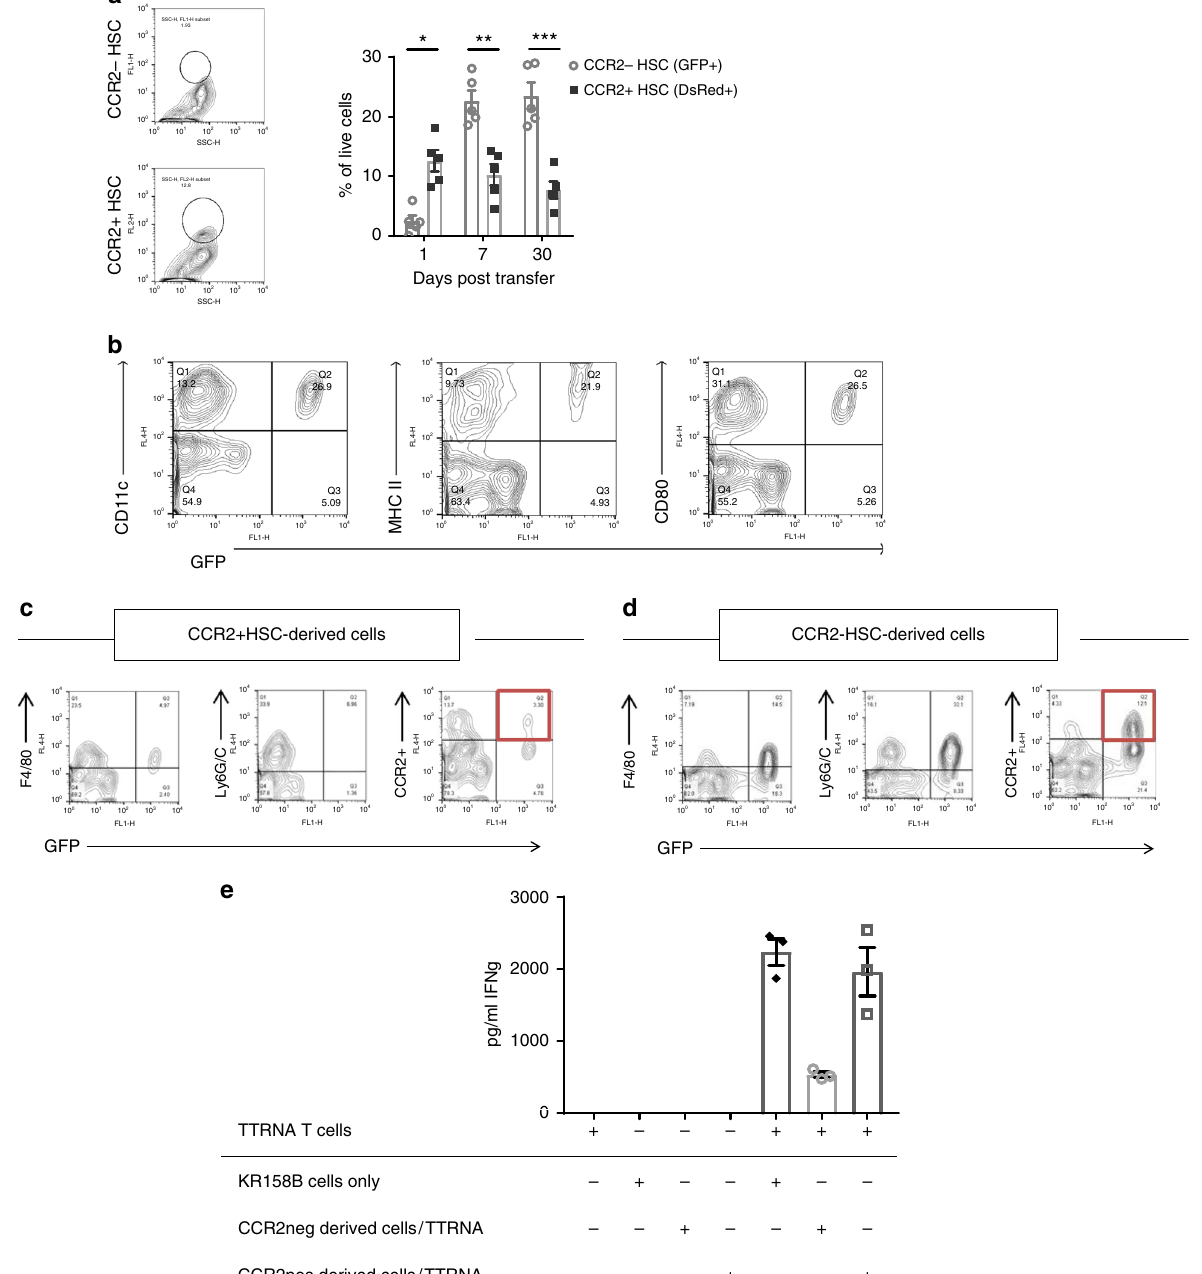
Fig. 4 CCR2 + HSCs migrate to intracranial tumor and differentiate into dendritic cells. a Equal numbers of CCR2 − HSCs (isolated from GFP mice) and CCR2 + HSCs (isolated from DsRed mice) were injected into tumor-bearing mice. Relative amounts of cells derived from either GFP + CCR2 − HSCs and DsRed + CCR2 + HSCs were compared at 1 day (* p = 0.0010), 7 days (** p = 0.0013), and 30 days (*** p = 0.0003) post transfer (Mann – Whitney tests; n = 7 mice per group). b In a separate experiment, CCR2 + HSCs were isolated from GFP + mice and intravenously co-transferred into tumor-bearing mice that received adoptive cell therapy with tumor-reactive T-cells. Twenty-one days post transfer, GFP + cells found in the tumor were phenotyped for makers of dendritic cells. c , d Both CCR2 − HSCs and CCR2 + HSCs were isolated from GFP + mice and co-transferred into tumor-bearing mice that received adoptive cell therapy with tumor-reactive T-cells. Twenty-one days post transfer, GFP + cells found in the tumors were analyzed for markers of a suppressive phenotype. e CCR2 − HSCs and CCR2 + HSCs were isolated and cultured in vitro in dendritic cell media containing GM-CSF and IL-4. Resulting cells were electroporated with total tumor RNA and used as targets for tumor-reactive T-cells. Supernatant IFN γ was measured (* p = 0.0135, *n/s p = 0.5176, n = 5 replicates, unpaired t -test). All error bars represent